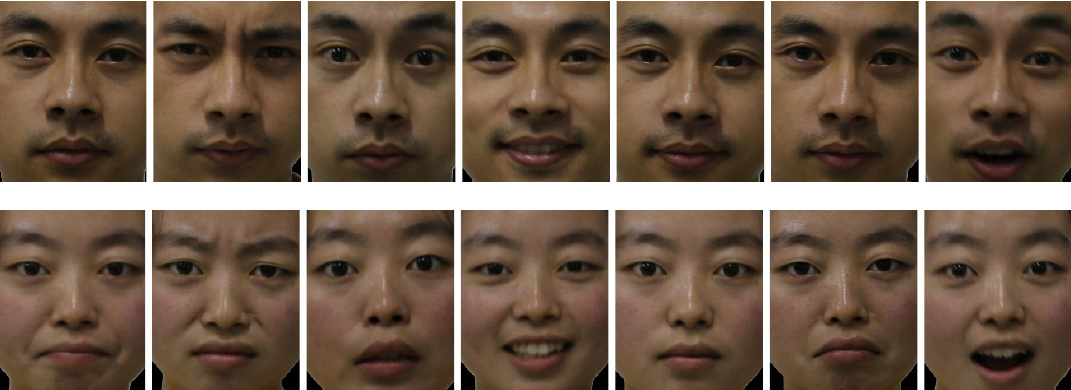
Figure 1. Samples of our